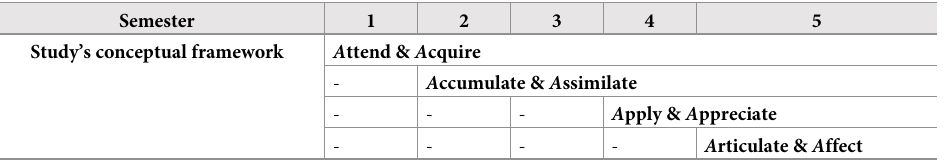
Table 3. Mapping the study’s conceptual framework (output of analysis of the qualitative component of this study) onto the courses of the research module under investigation.